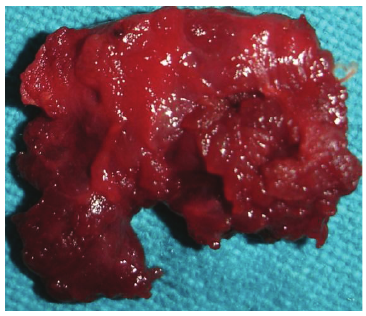
Figure 10: Resected masseter muscle.